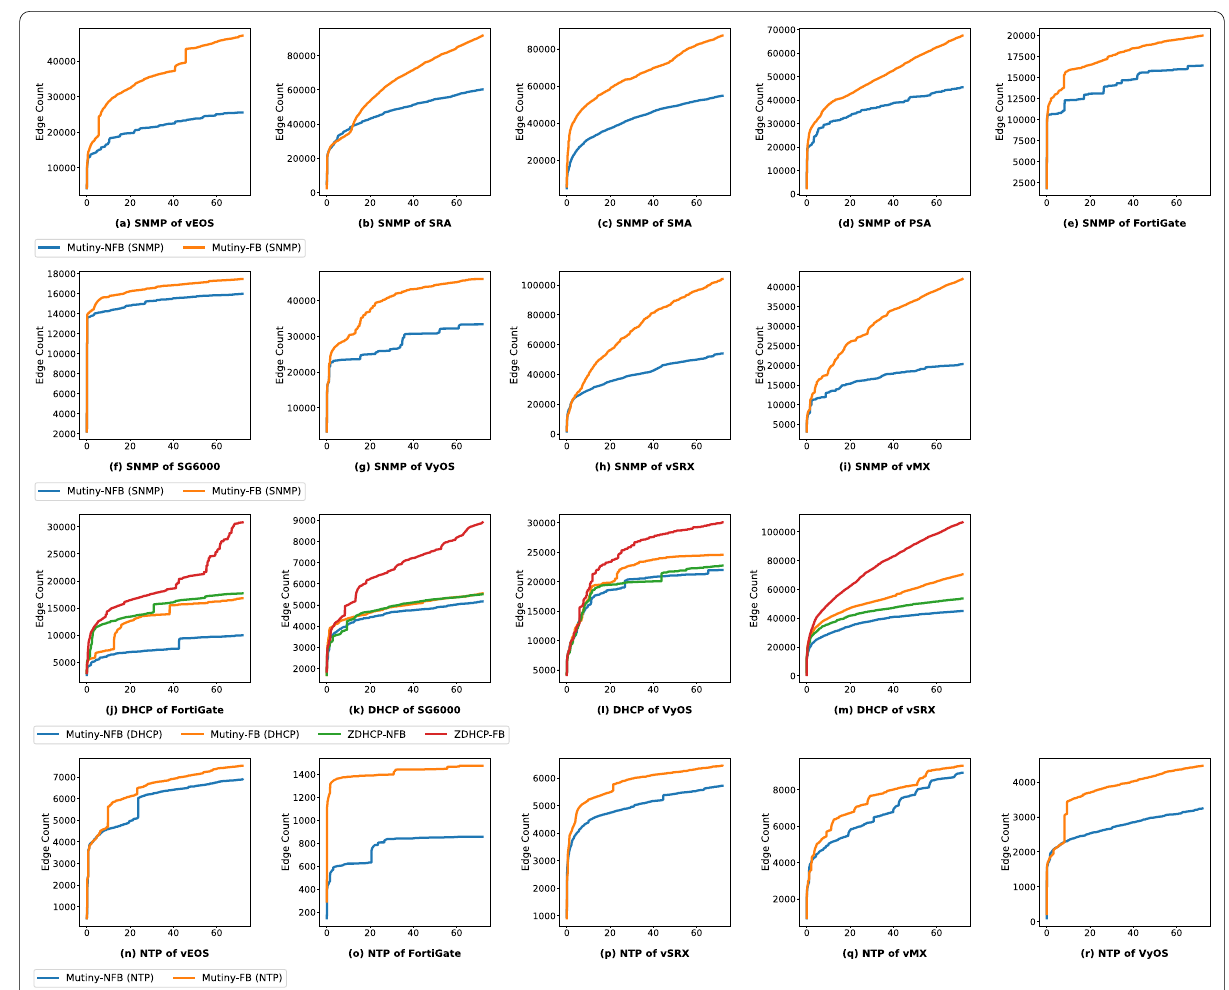
Fig. 5 Edge count trend of the 9 SNMP, 4 DHCP and 5 NTP fuzzing instances for 72